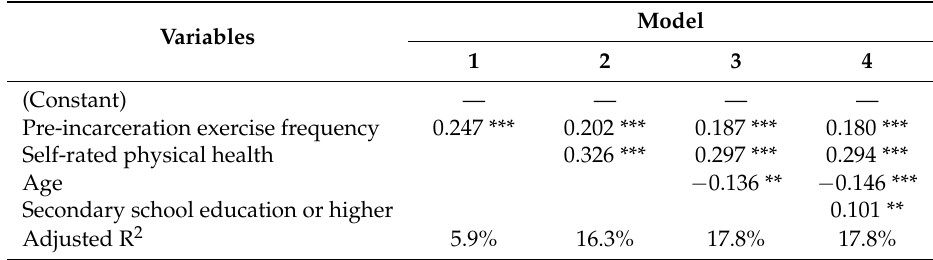
Table 2. Adjusted models explaining variance in exercise frequency during incarceration of inmates with harmful substance use ( n = 605)